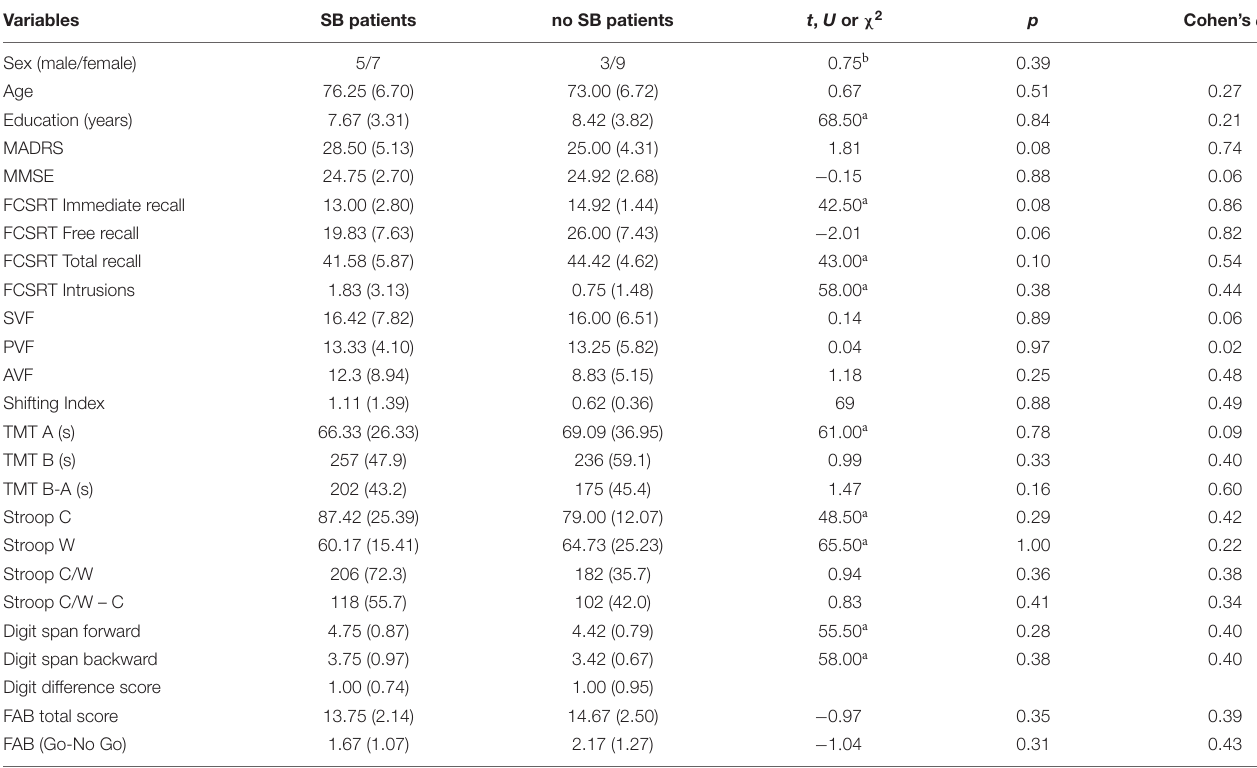
TABLE 1 | Demographic, clinical, and neuropsychological characteristics of the study sample. Variables SB patients